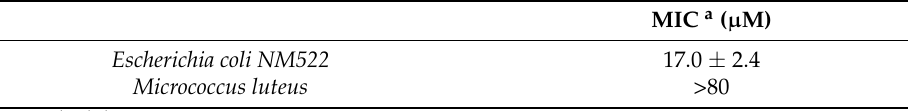
Table 1. Antimicrobial activities of BCR4 peptide.